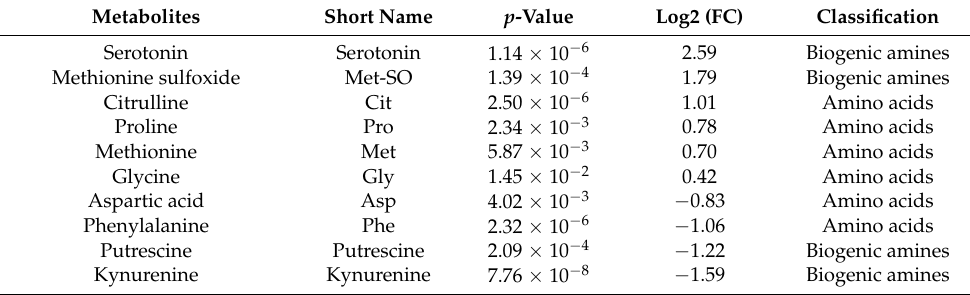
Table 2. List of identified and significantly changed metabolites in serum of dogs infected with B. canis versus healthy dogs obtained by targeted LC-MS metabolomics